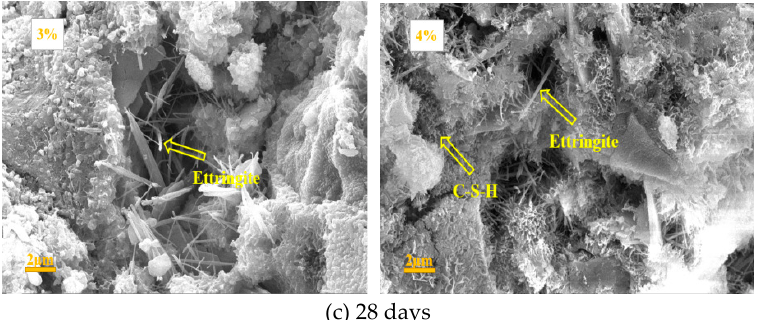
Figure 10. SEM results of the mixes with different contents of Na 2 CO 3 at ages of ( a ) 1, ( b ) 7, and ( c ) 28 days.